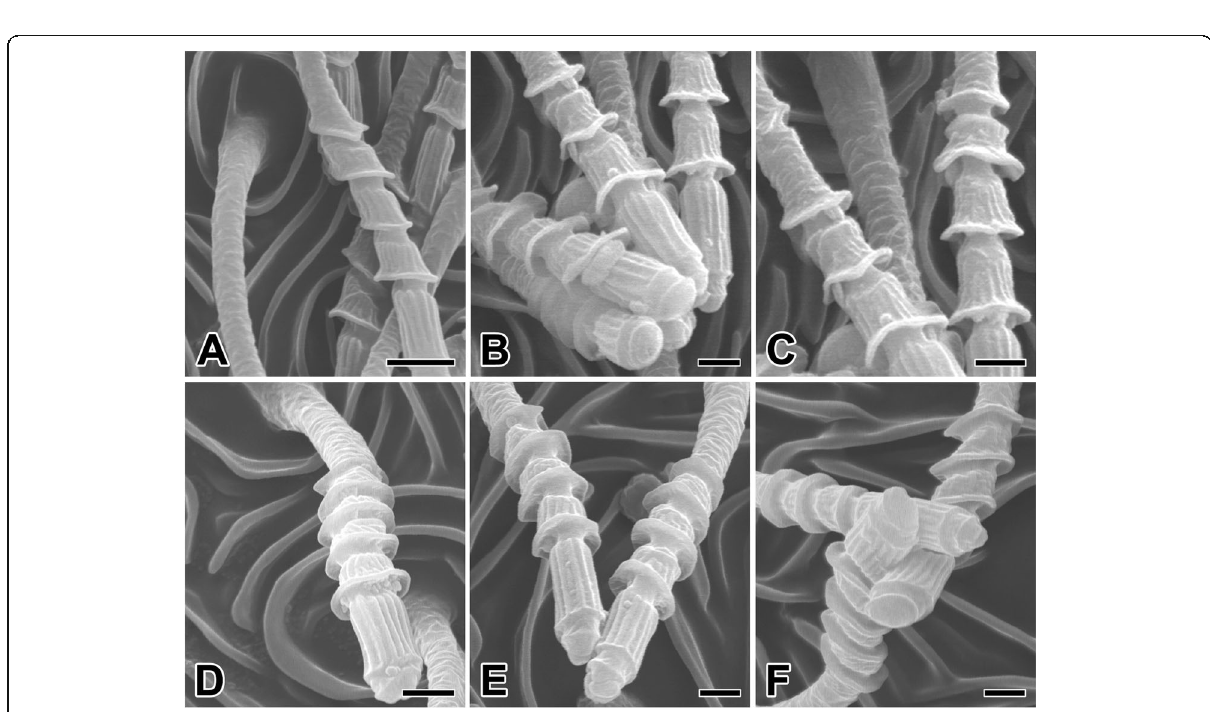
Fig. 5 High magnification scanning electron micrographs of the cribellate spigots in N. albofasciata . a-c Cuticular surface of the cribellum is covered by hundreds or thousands of tiny, elongate spigots, each producing a single fibril of cribellate silk. d-f All of these spigots are composed of five tubal segments with four thicker regions. Each cribellar spigot shows segmented flexible structure which enable to bent itself and conjoin together with adjacent spigots. Scale bars indicate 1 μ m ( a ) and 0.5 μ m ( b-f